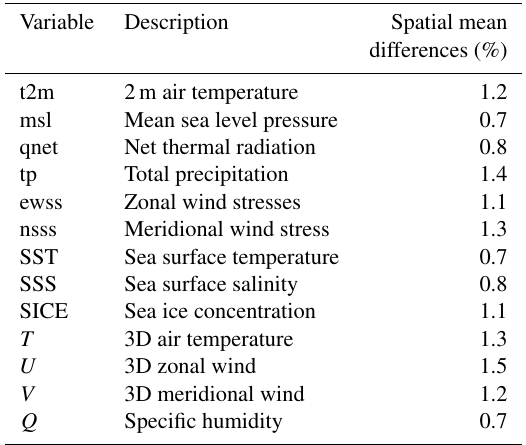
Table 14. Difference in the 20-year mean and ensemble mean near- surface values for different variables between the Rhino and CCA platform